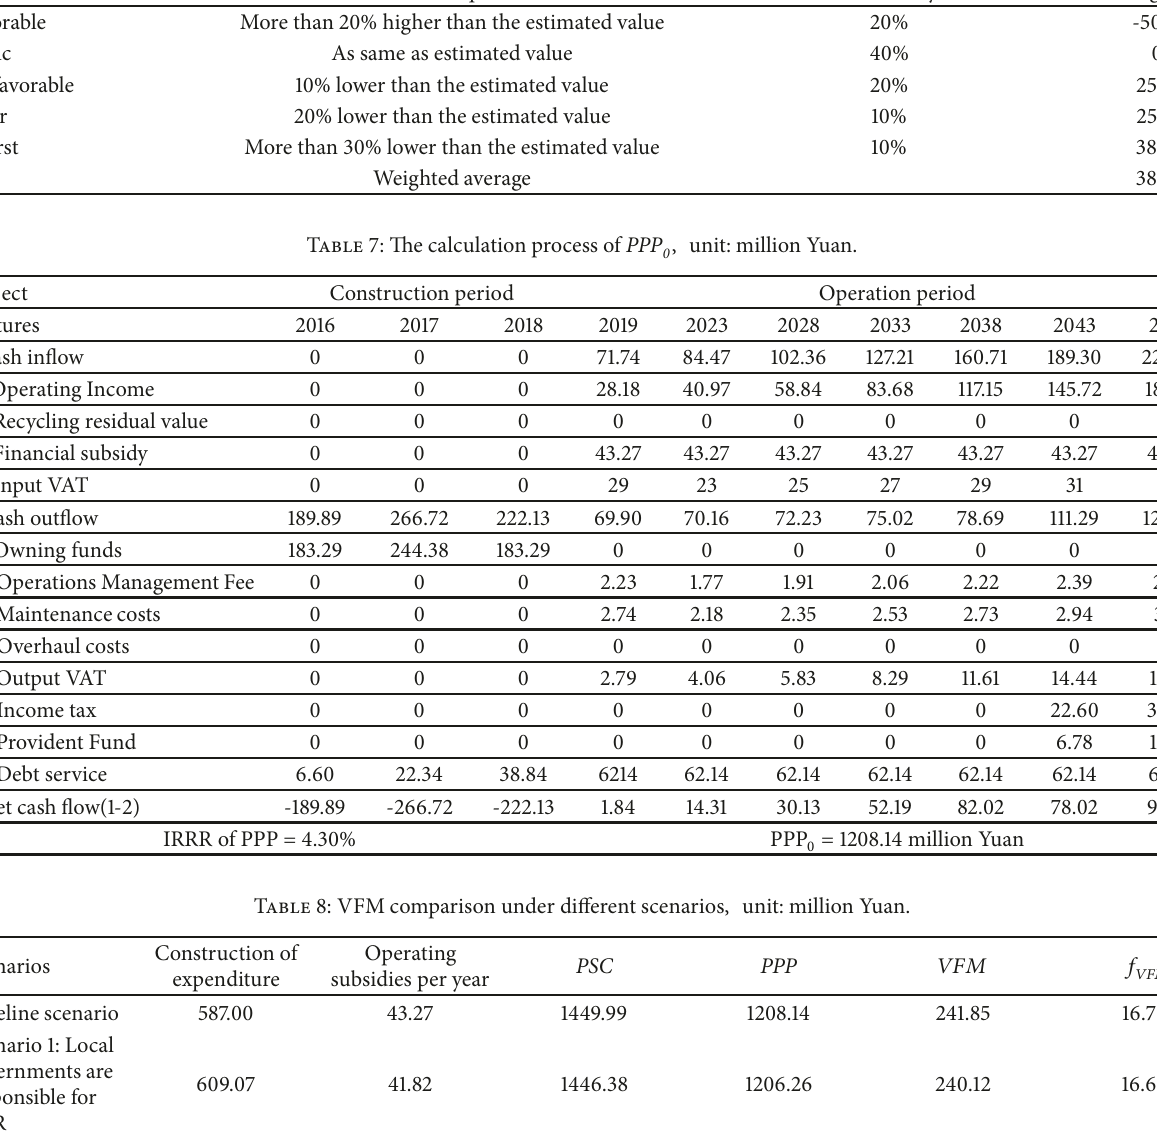
Table 6: The financial risks scenario of probabilistic methods, unit: million Yuan.